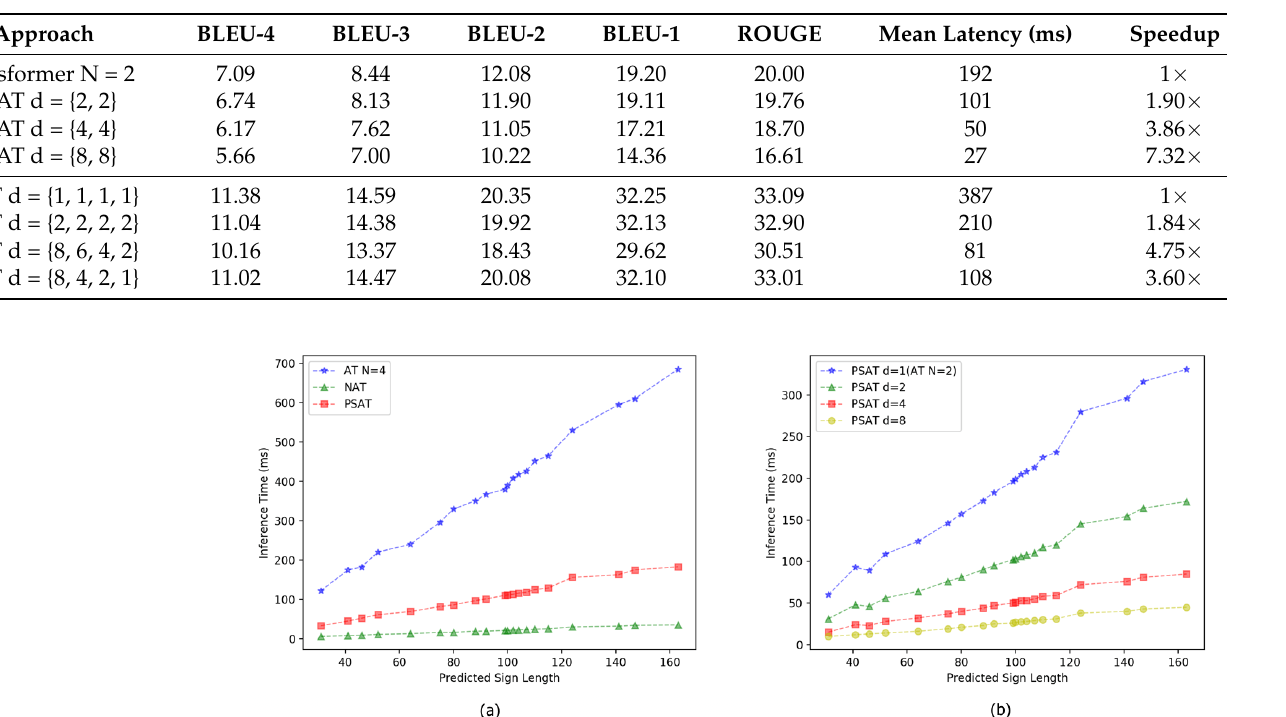
Table 1. Comparison of precision and speed in different configurations on RWTH-PHOENIX-Weather- 2014T.